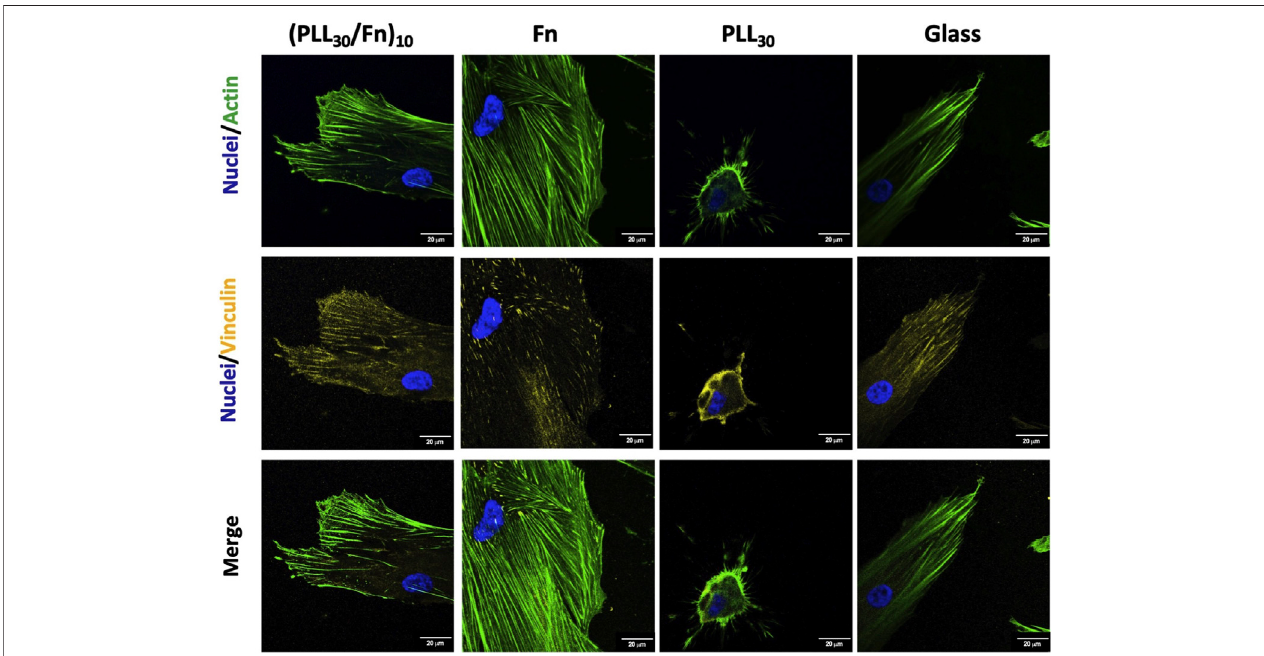
FIGURE 5 | Representative fl uorescence microscopy images of cell adhesion of human gingival fi broblasts (HGF) on (PLL 30 -Fn) 10 fi lms, Fn monolayer, PLL 30 coating, and glass coverslip analyzed by immunostaining: nuclei (DAPI-blue), actin (phalloidin-green), and vinculin (TRITC-yellow) after 4 h of incubation. Scale bar (cid:1) 20 μ